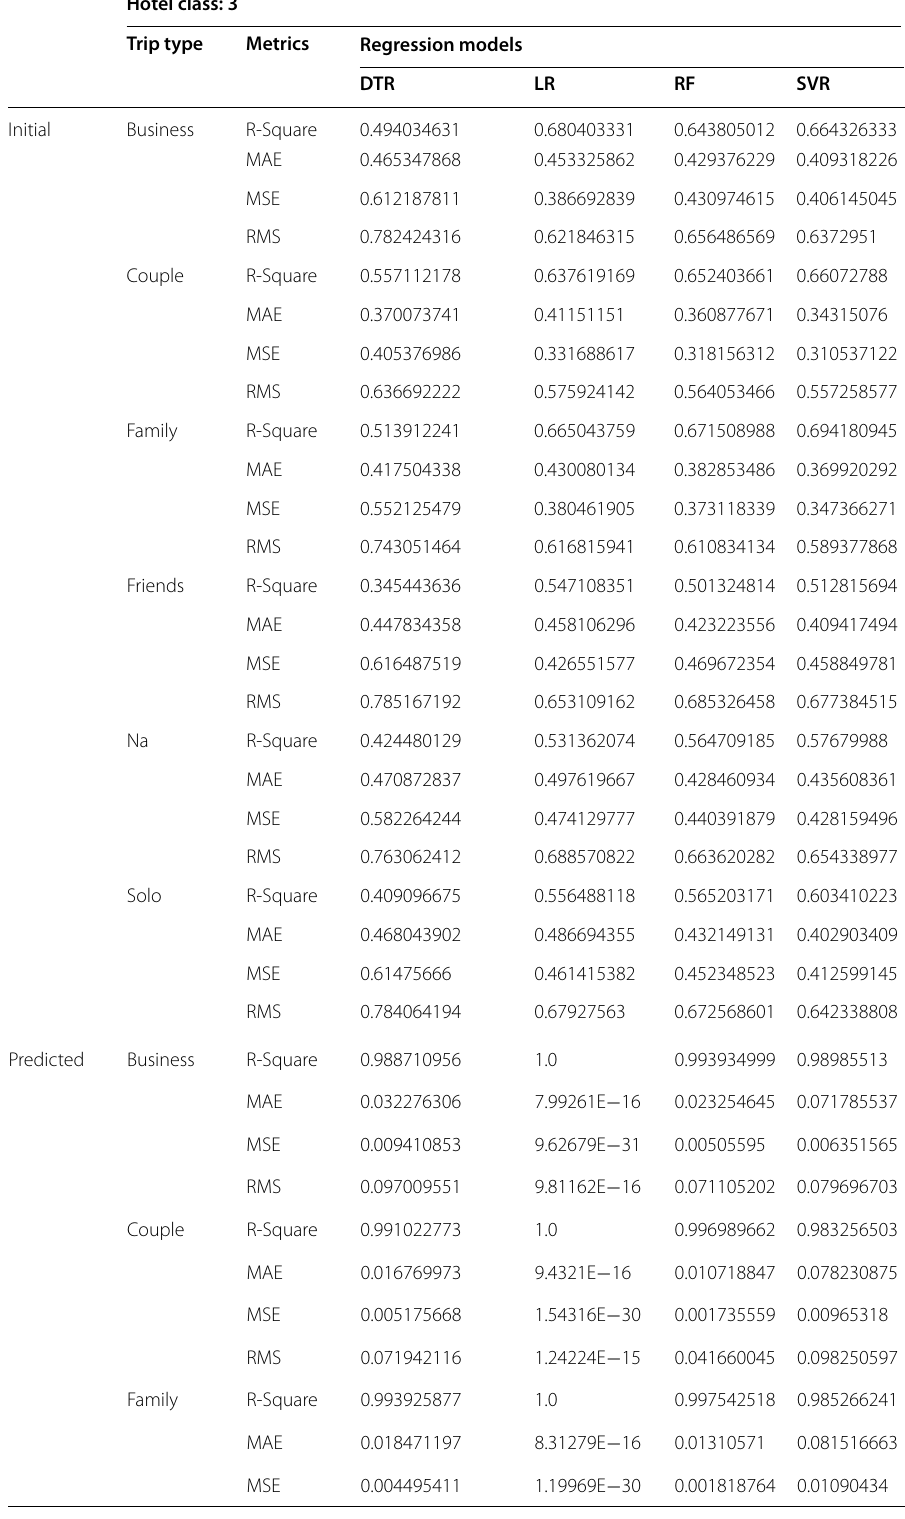
Table 5 Accuracy analysis on 3 star hotel class based on trip type (Initial and predicted results) Hotel class: